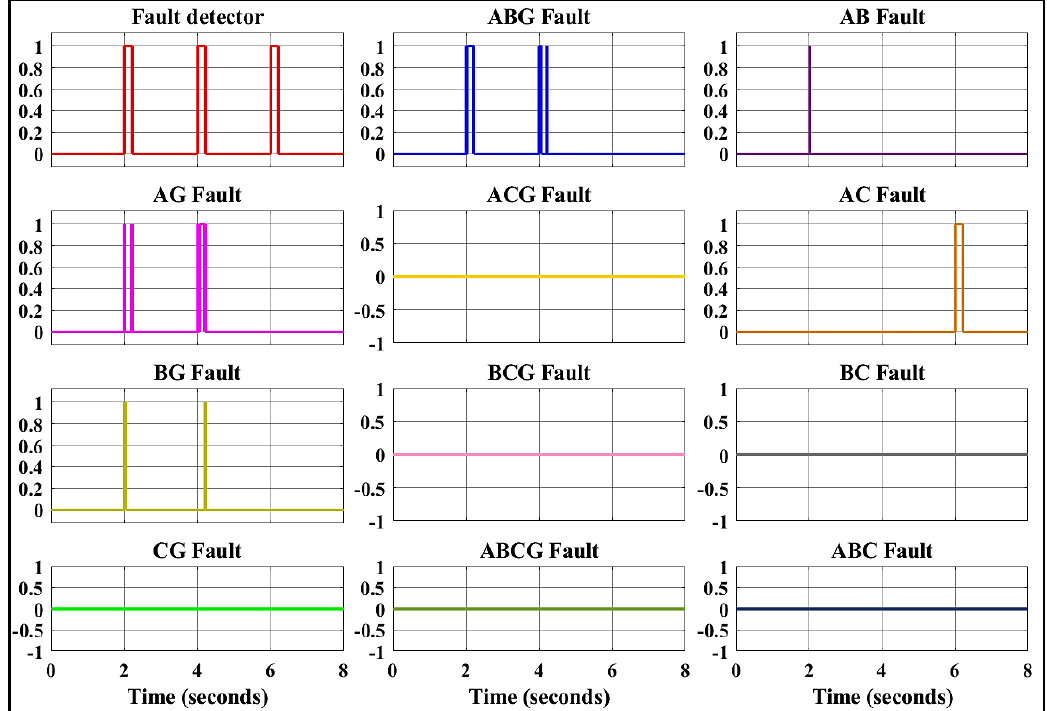
Figure 17. Fault detection and classification .